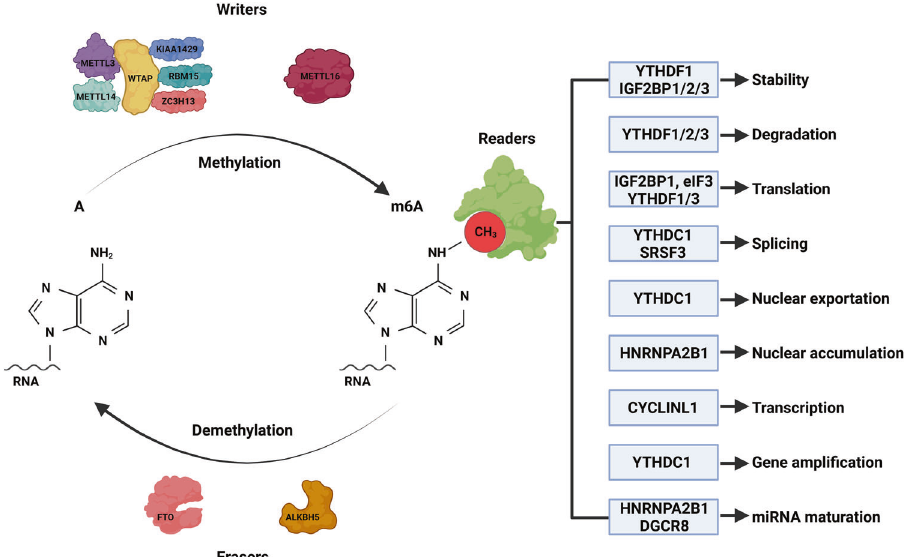
Fig. 1 The structure and reversibility of m6A modi fi cations and the function of m6A through recognition by the reader protein. m6A modi fi cation refers to the methylation of the sixth N atom of adenine in RNA molecules, which can be catalyzed by the MTC writing complex consisting of the core components of METTL3-METTL14-WTAP and other regulatory cofactors or by METTL16 alone. The m6A site on RNA can be recognized by the reader protein, causing changes in RNA function, and can also be reversibly removed by the erasure protein FTO or